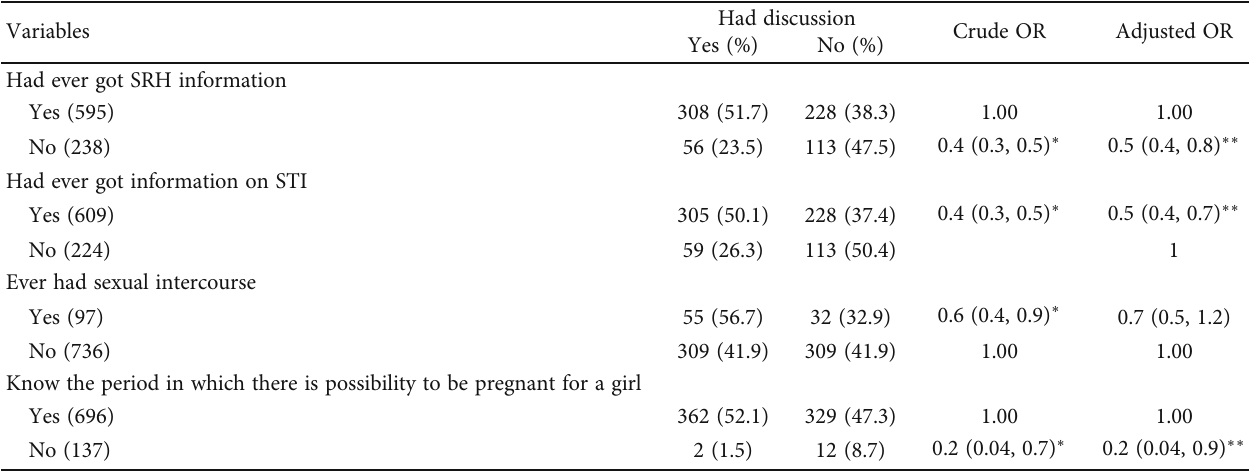
Table 3: Factors associated with adolescent-parent communication on SRH matters among rural adolescents in Jimma Zone, Southwest Ethiopia,